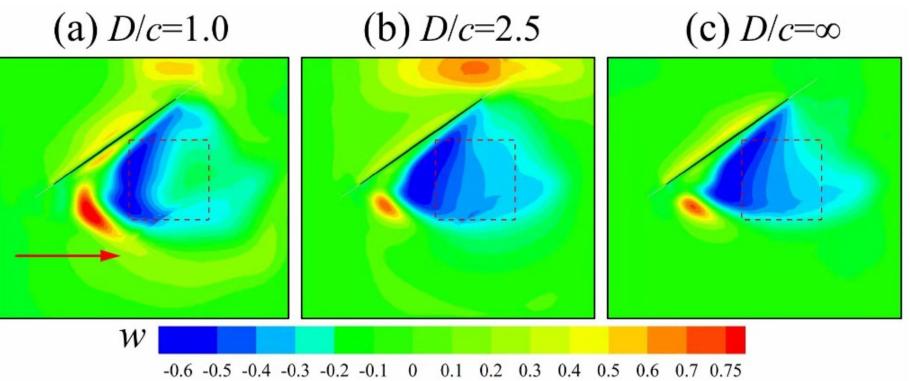
Figure 20. The vertical velocity ( w ) contours on the stroke plane (top view) with vortex wake at the beginning of a stroke for ( a ) D / c = 1.0; ( b ) D / c = 2.5; and ( c ) D / c = ∞ at Re = 100. The dashed boxes indicate the regions encountered by the wing at mid-stroke. The wing’s stroke direction is given by the red